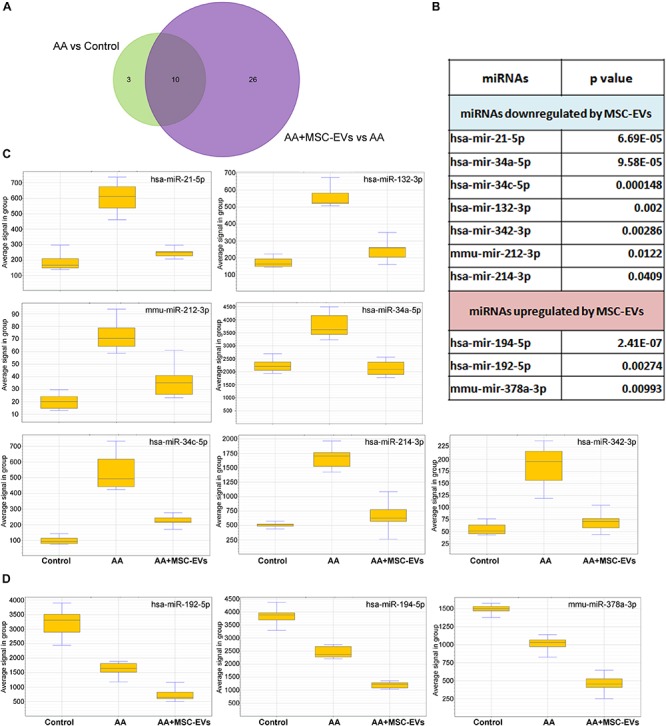
FirePlex miRNA assay. miRNAs, regulated in kidney toxicity, were detected in paraffin kidney sections in mice from all experimental groups (n = 3 per group). (A) Venn diagram comparing the miRNAs regulated by AA and by MSC-EVs in the AAN model. Thirteen miRNAs were dysregulated in AA intoxicated mice with respect to control mice and 36 in AA mice treated with MSC-EVs. Ten miRNAs were found to be common between the two groups. (B) List of the 10 modified miRNAs common between AA mice and AA mice treated with MSC-EVs. (C) Box plots representing the miRNAs that were upregulated in mice injured with AA and downregulated following treatment with MSC-EVs. (D) Box plots representing the miRNAs that were common between AA mice and AA mice treated with MSC-EVs but not downregulated.